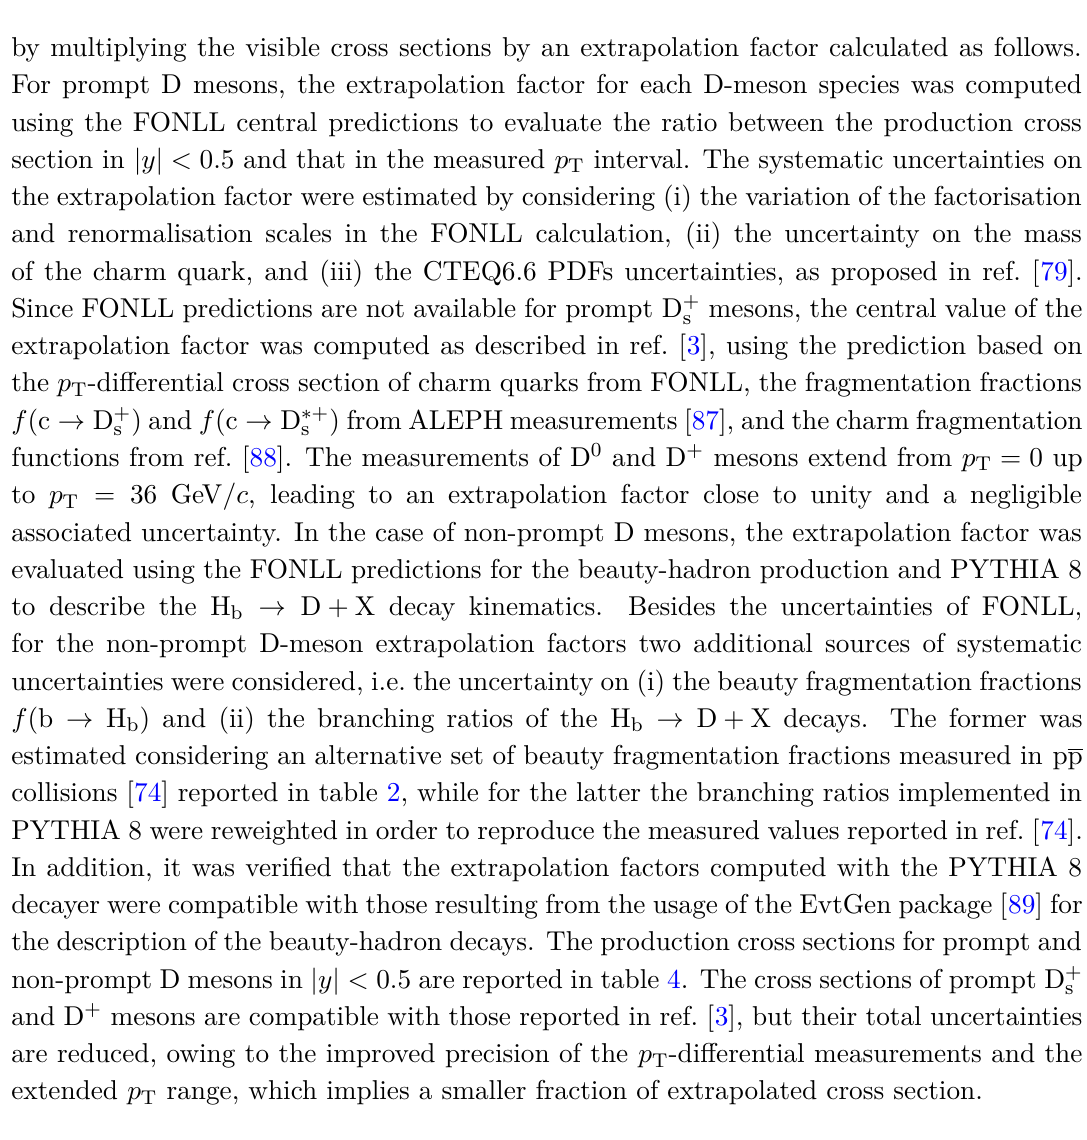
Table 2 . Fragmentation fractions of b-quarks into beauty-hadron species in Z → bb decays, and √ in pp collisions at s = 1 . 96 TeV